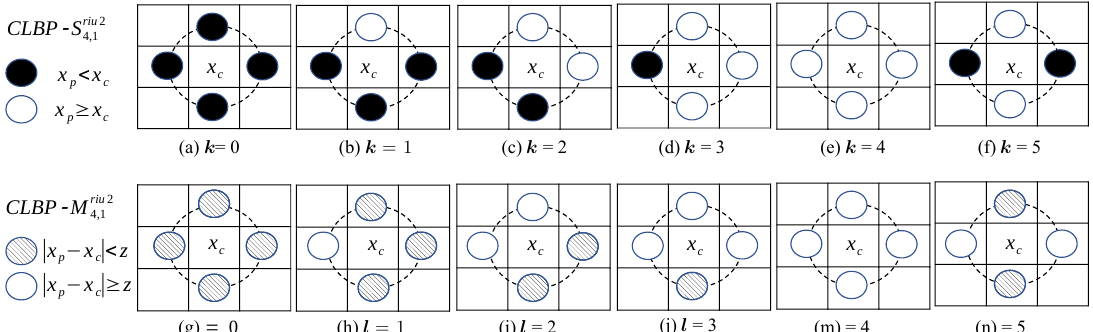
Figure 1. The patterns in the upper row correspond to CLBP-S riu 2 , which compares the gray value of the 4,1 central pixel of a patch ( x c ) with the gray values of its four neighbors ( x p ). The black and white disks denote smaller and greater values than those of the central pixel value, respectively. In the lower row, CLBP-M riu 2 4,1 compares the absolute values of the differences of the gray values of the central pixel and its neighbors (| x c − x p | ) with the threshold z from Equation (3). The hatched and white disks denote smaller and greater absolute values than those of the threshold, respectively. Note that the patterns are rotation invariant. Thus, in the case of P = 4 shown here, the patterns for k , l = 1,2,3,5 may be rotated by multiples of 90 degrees without changing the values of CLBP-S riu 2 and CLBP-M riu 2 4,1 4,1